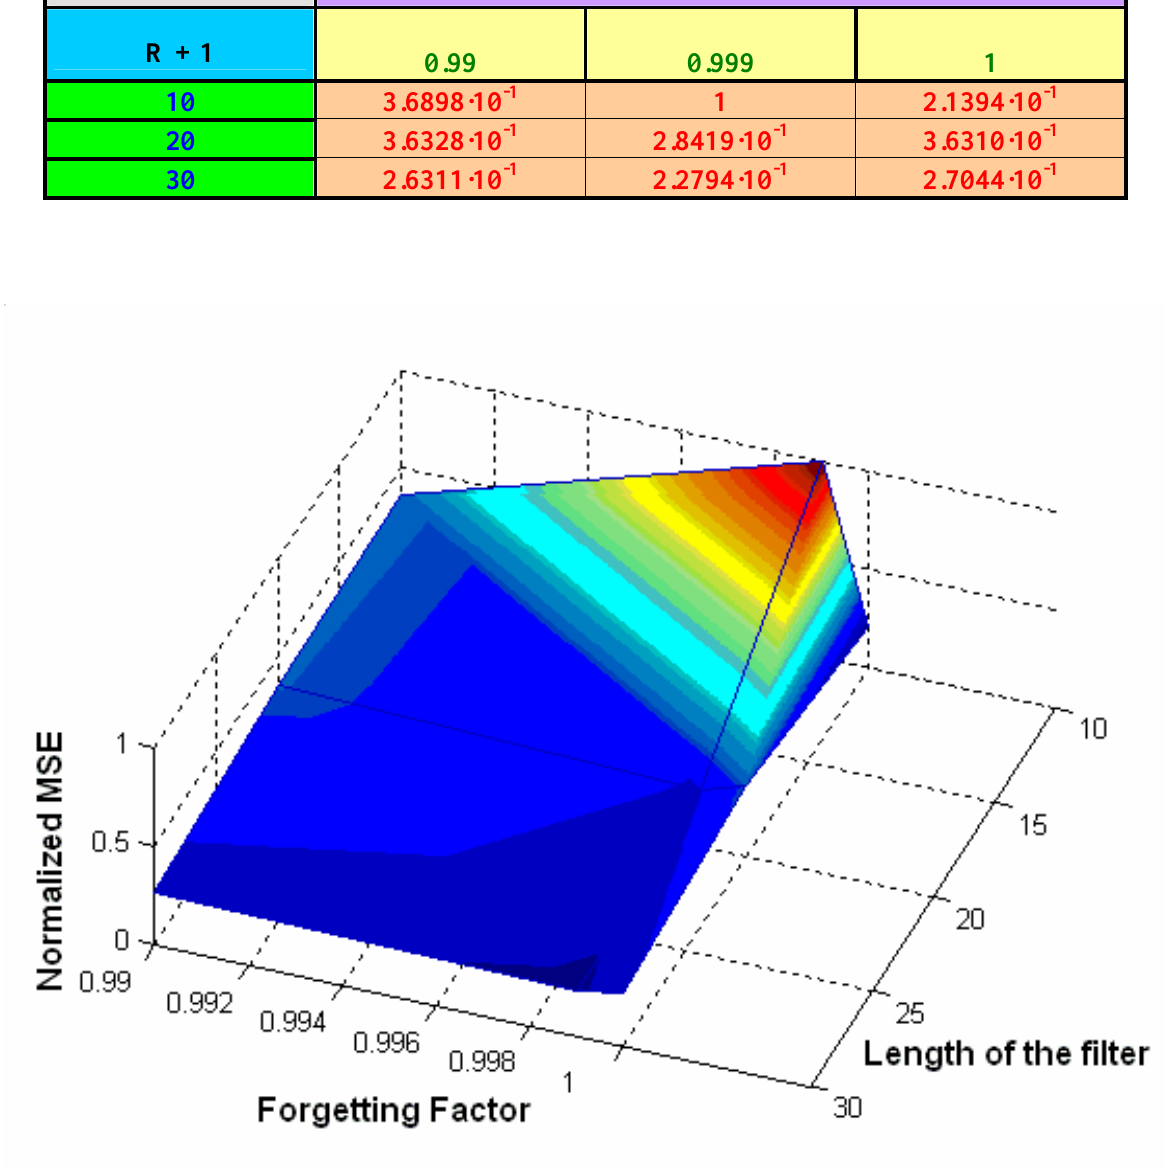
Figure 5. Normalized mean-squared error performance surface of the